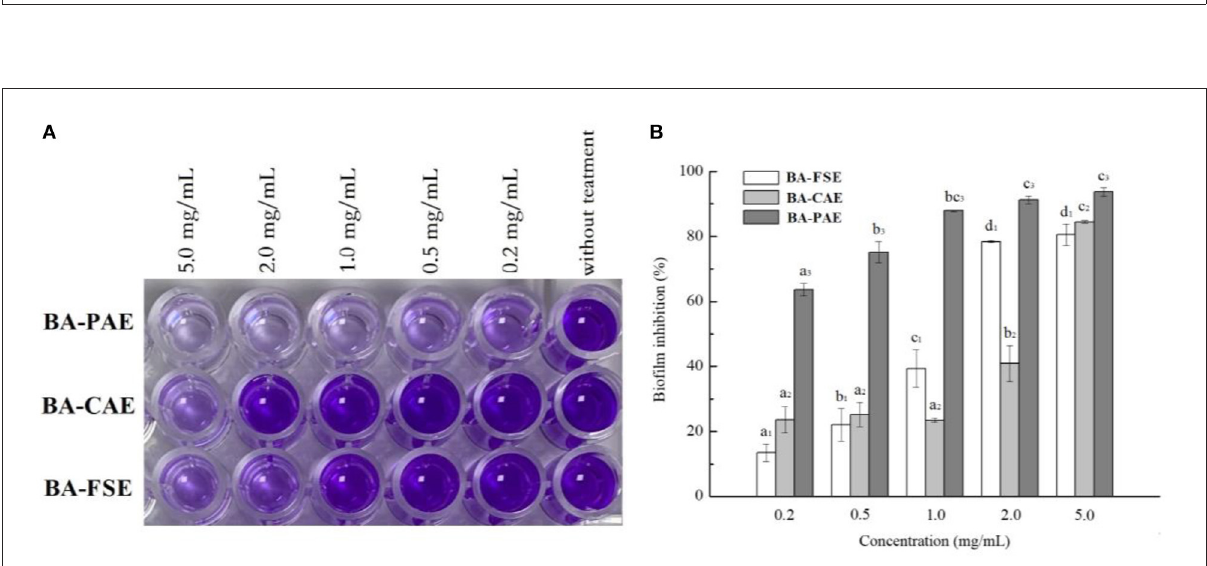
FIGURE6 Effects of different blackberry extracts on biofilm formation in Listeria monocytogenes . (A,B) Demonstrated the results related to cell staining reaction and biofilm inhibition, respectively. The mean values for the same extract with different lowercase letters were significantly different at the level of